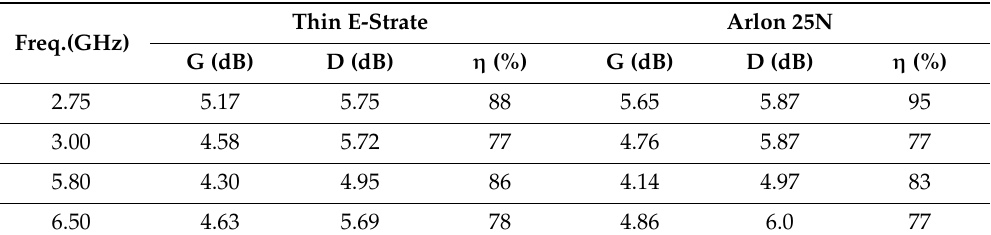
Table 5. Radiation properties of the CPW-fed monopole antenna obtained in measurement for the CPW-fed monopole antenna on ENrG’s Thin